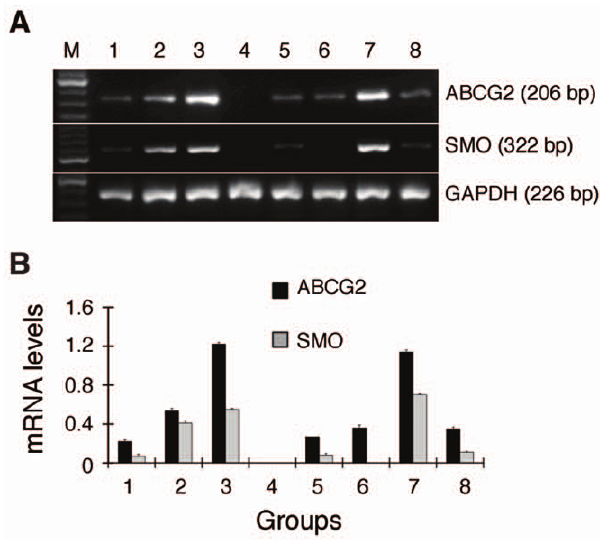
Figure 5. RT-PCR analysis of ABCG2 and SMO mRNA levels. A, Representative RT-PCR gel images. M, marker; lane 1, NCI-H460 cells normally cultured in serum-containing medium; lane 2, the H460 spheres; lane 3, purified SP cells; lane 4, purified non-SP cells; lane 5, the Tomatidine control group; lane 6, the Cyclopamine experimental group; lane 7, SP tumors; lane 8, non-SP tumors. B, Quantitative presentation of ABCG2 and SMO mRNA levels as determined by densitometry ( P , 0.001, except ABCG2 mRNA lane 6 vs. lane 8 and SMO mRNA lane 1 vs. lane 5 and lane 4 vs. lane 6).